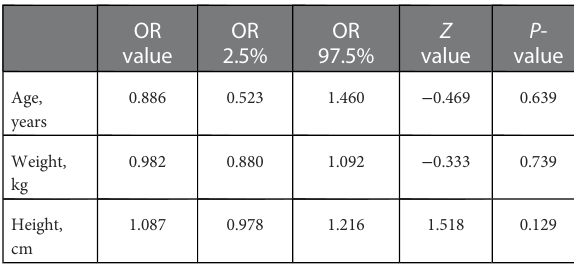
TABLE 2 Multifactor logistics regression analysis of risk factors for surgical failure of